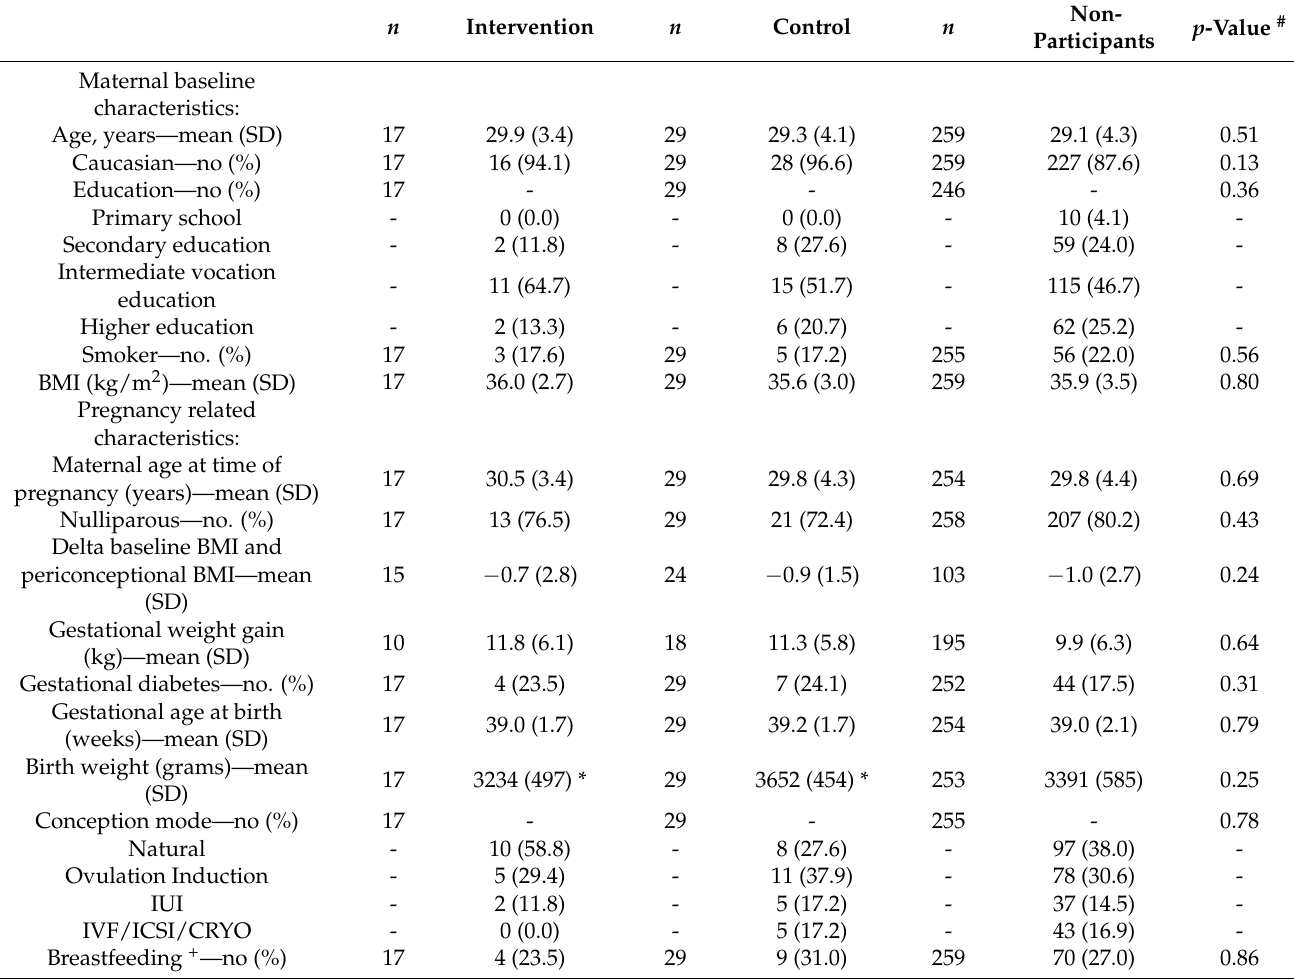
Table 1. Maternal baseline and pregnancy related